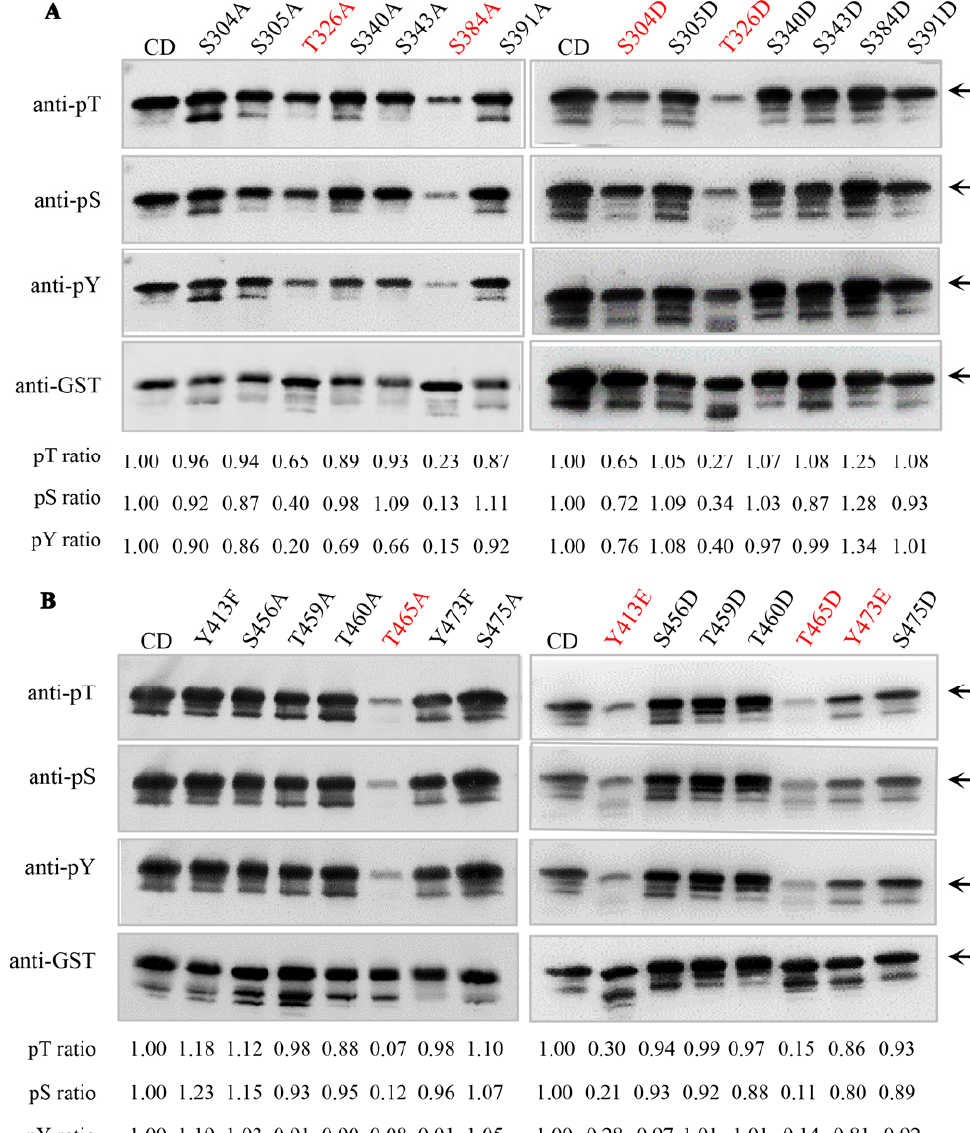
Figure 2. Identification of key autophosphorylation residues of AtSARK by site-directed mutagenesis and Western blot analysis. Each of the potentially phosphorylated Ser and Thr residues identified by LC-MS/MS was replaced with either an alanine ( A ), which cannot be phosphorylated, or an aspartic acid (D), which mimics phosphorylation. Each of the Tyr residues was substituted with either a phenylalanine (F) to mimic dephosphorylation or a glutamic acid (E) to mimic phosphorylation. The site-directed mutant proteins were subjected to in vitro autophosphorylation assay as described in Section 4. Autophosphorylation level was evaluated by Western blotting with anti-phospho-Ser (anti-pS), anti-phospho-Thr (anti-pT), and anti-phospho-Tyr (anti-pY) antibodies. The wild-type or mutated AtSARK-CD protein loaded in each lane was examined using anti-GST antibody. The molecular weight of AtSARK-CD protein is 72 kDa and phosphorylated bands of interests in each blot are indicated with black arrows. Numbers below the blots indicate the intensity ratio of the anti-pS, anti-pT, or anti-pY band to the anti-GST band of the indicated mutant protein with those of the wild-type AtSARK-CD protein normalized to 1. The results of site-directed mutants of S304, S305, T326, S384, and S391 residues are shown in panel ( A ), while those of Y413, S456, T459, T460, Y473, and S475 residues are shown in panel ( B ). The mutants with significantly reduced autophosphorylation level are highlighted in red. Data shown are the typical results obtained from three independent biological replicates. CD,